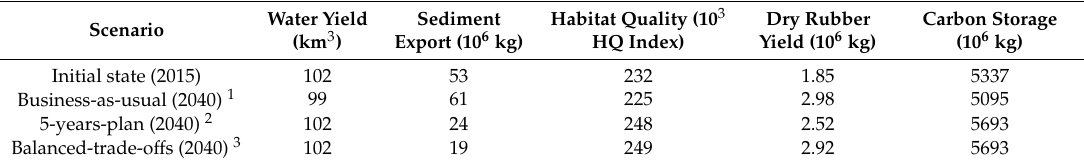
Table 4. Ecosystem service provision determined by InVEST at the initial state of 2015, as well as the final year (2040) of each scenario for the Nabanhe Reserve (271 km 2 ).